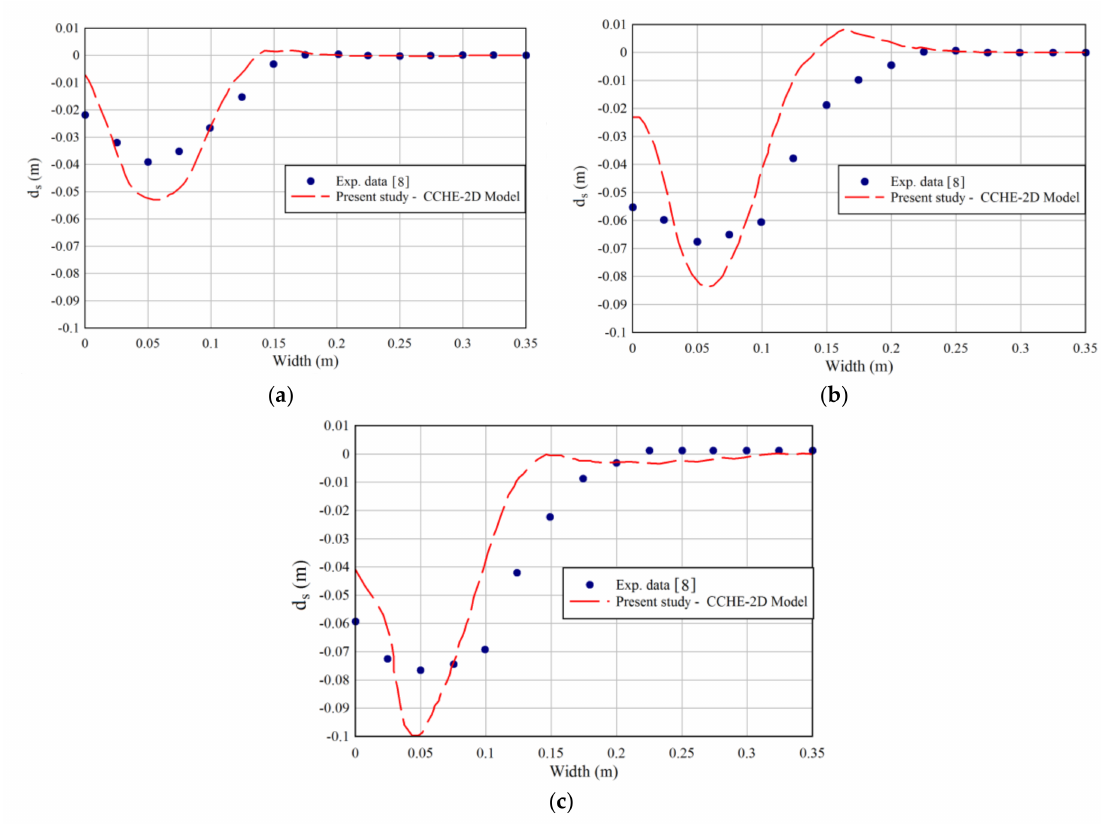
Figure 8. Comparison between experimental data and numerical results ( θ = 60 ◦ ). ( a ) Run 7; ( b ) Run 8; ( c ) Run